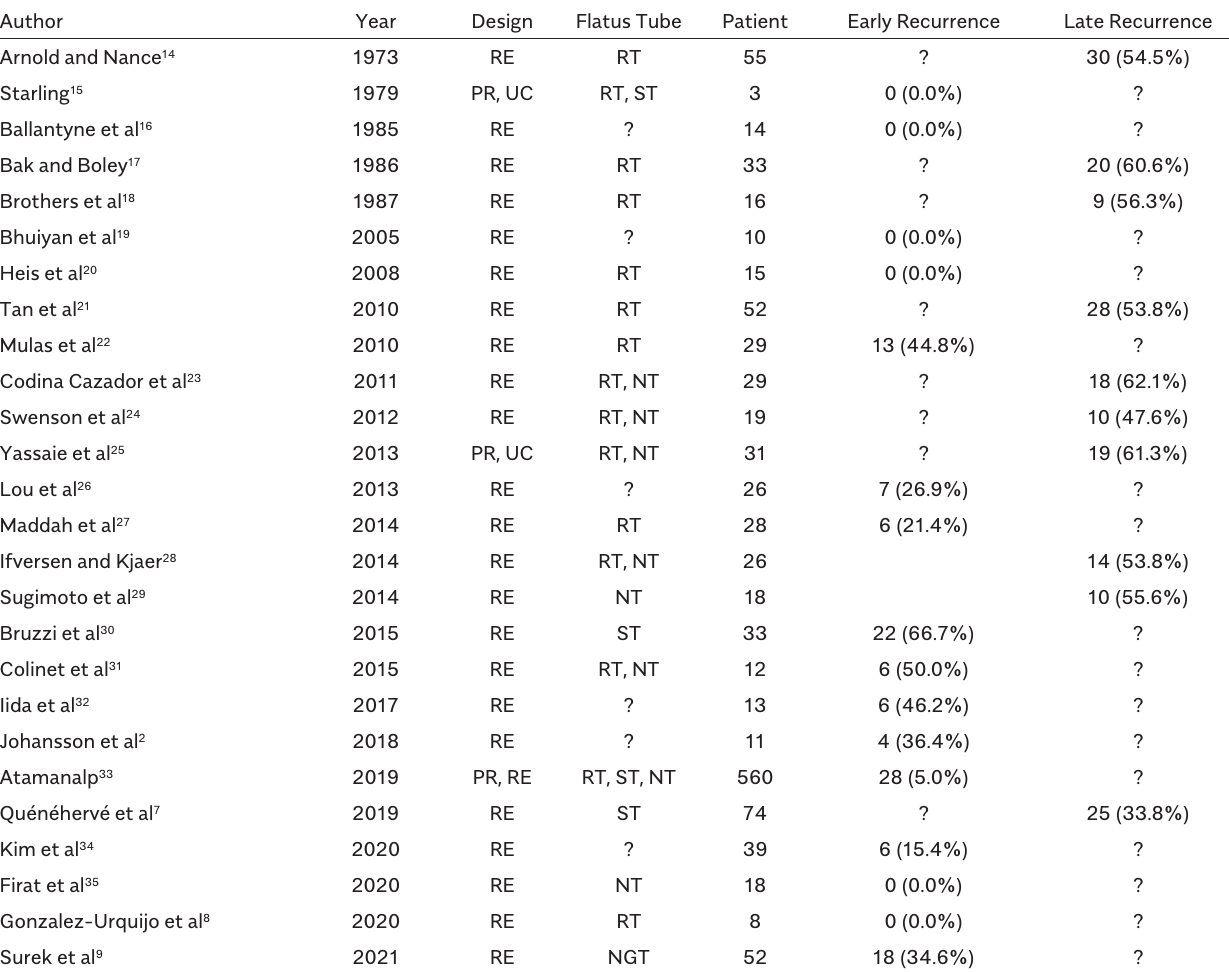
Table 2. Data on Flatus Tube Placement Following Successful Endoscopic Decompression and Early Recurrence in Sigmoid Volvulus